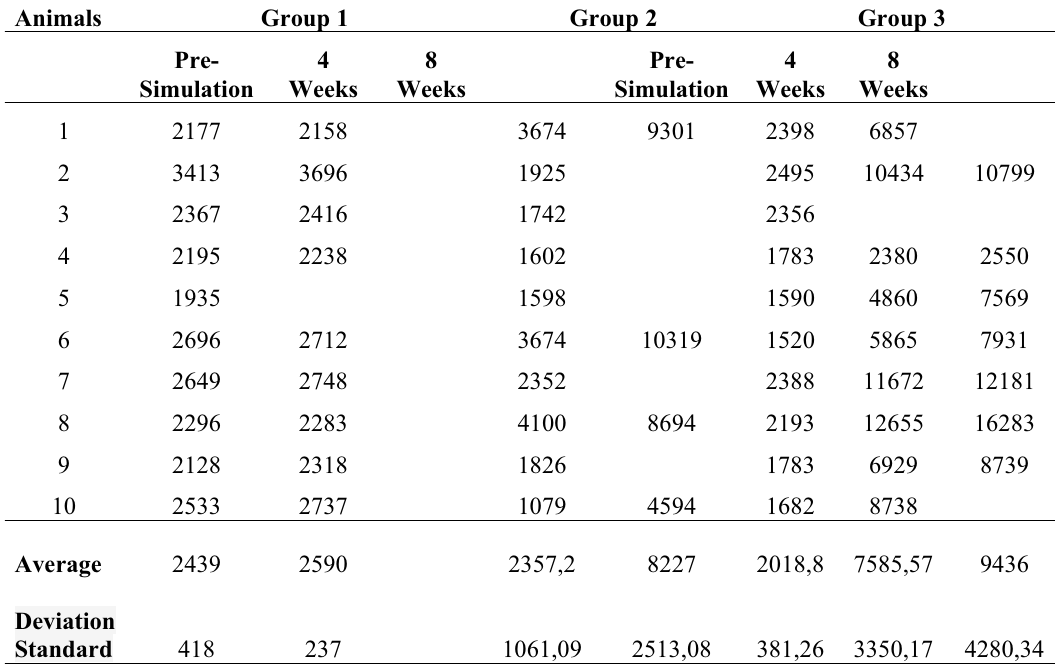
TABLE 2 - Ventricular volume ( mm 3 ) obtained by MRI in the animals